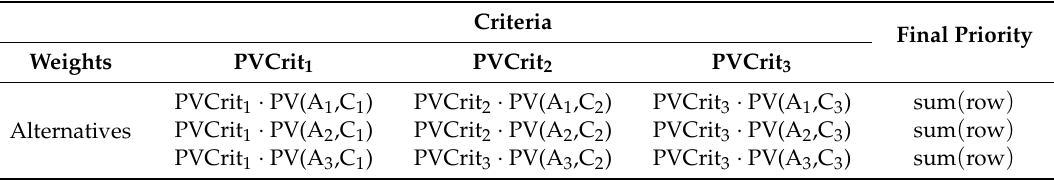
Table 5. The decision matrix providing the ranking of the